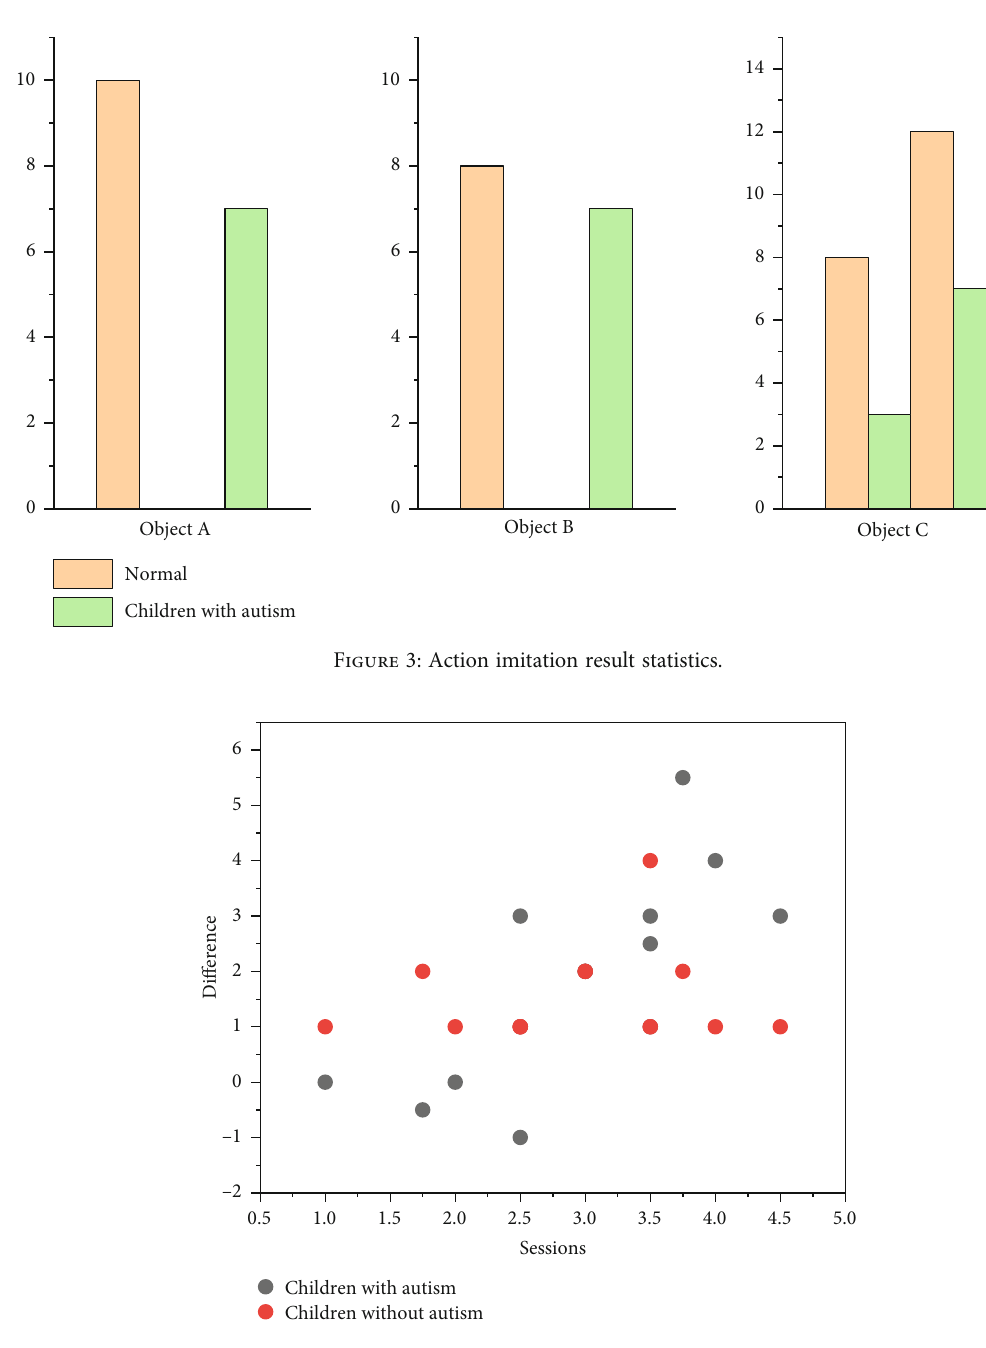
Figure 4: Developing a sense of rules for autism